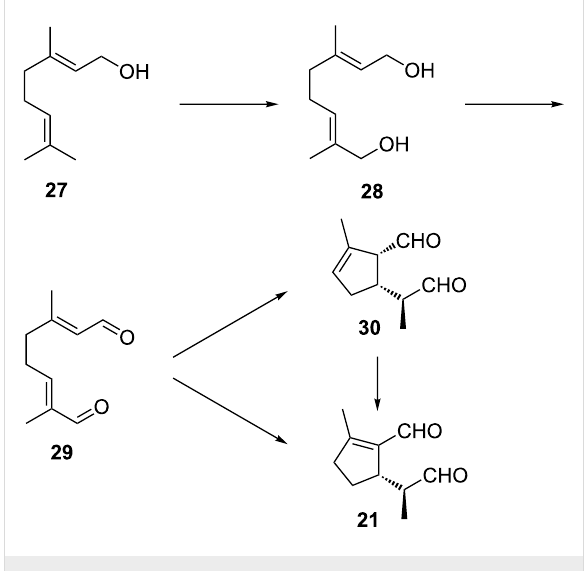
Figure 9: Biosynthetic ways to iridoids from